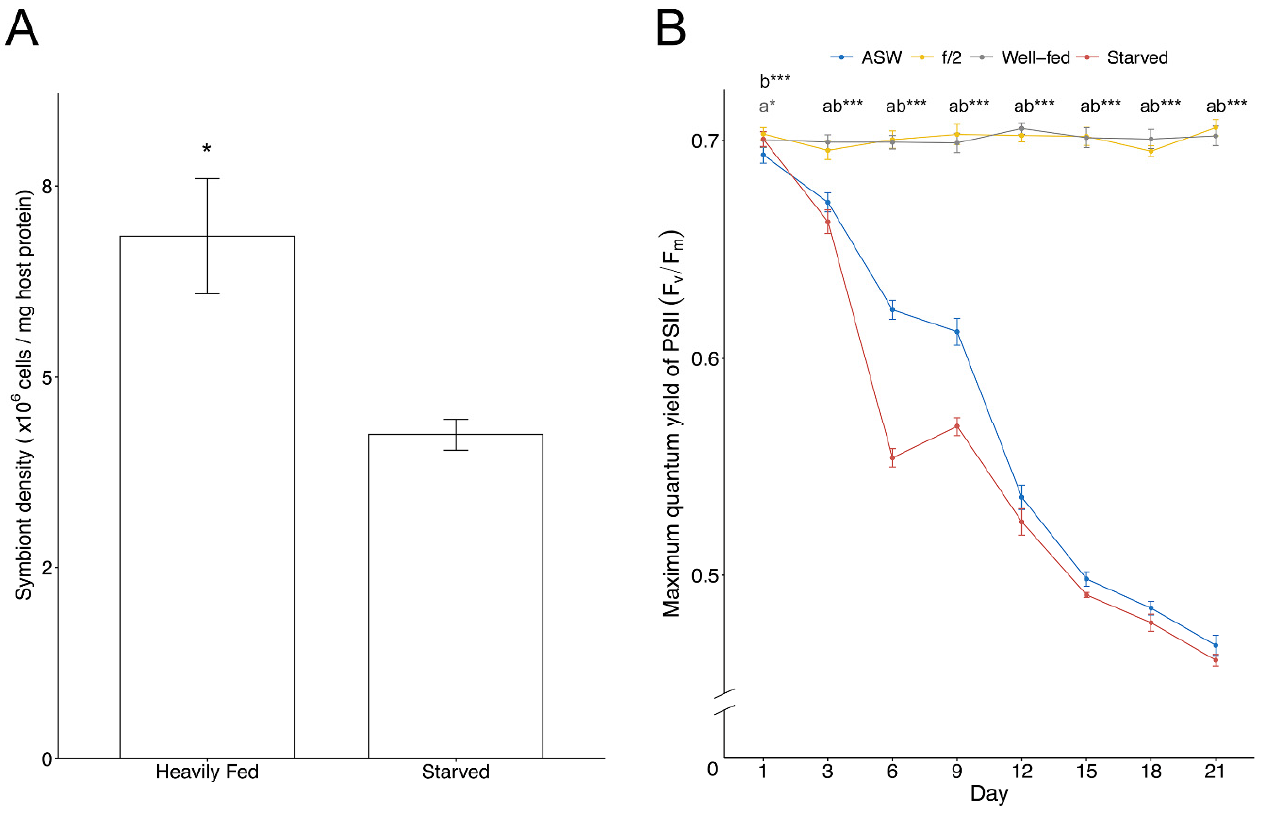
Figure 1. Physiological effects of different nutritional regimes in Breviolum minutum and Aiptasia. ( A ) Comparison of in hospite symbiont cell densities between well-fed and starved Aiptasia. n = 13 per treatment. ( B ) Maximum quantum yield of photosystem II (F v /F m ) of cultured algae (ASW vs. f/2 medium) and in hospite (well-fed vs. starved). n = 10 per treatment at each time-point. Asterisks indicate significant differences: * p < 0.05. ** p < 0.001, *** p < 0.0001. Different letters next to asterisks indicate significant differences between treatments, a (ASW and f/2), b (well-fed and starved). Values are mean ± SE.